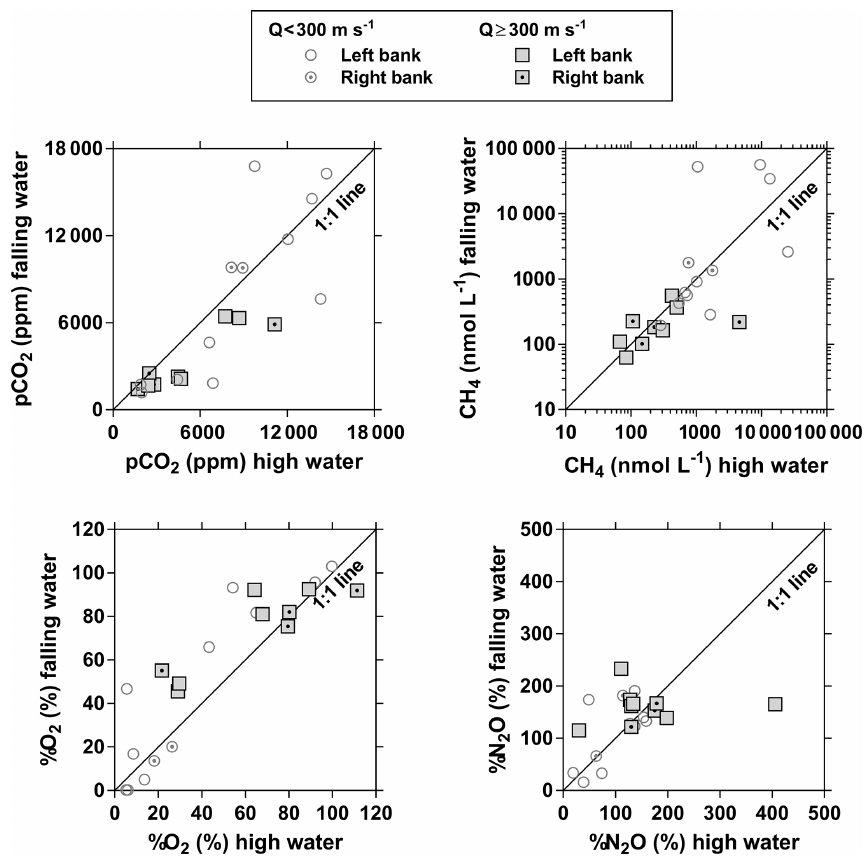
Figure 19. Comparison of the partial pressure of CO 2 ( p CO 2 in ppm), dissolved CH 4 concentration (nmolL − 1 ), dissolved O 2 saturation level (%O 2 in %), and dissolved N 2 O saturation level (%N 2 O in %) in surface waters of the Congo River tributaries sampled during both high water (3–19 December 2013) and falling water periods (10–30 June 2014). Tributaries were separated into left and right bank, as well as into large and small systems, with a freshwater discharge ( Q )<and ≥ 300m 3 s − 1 ,